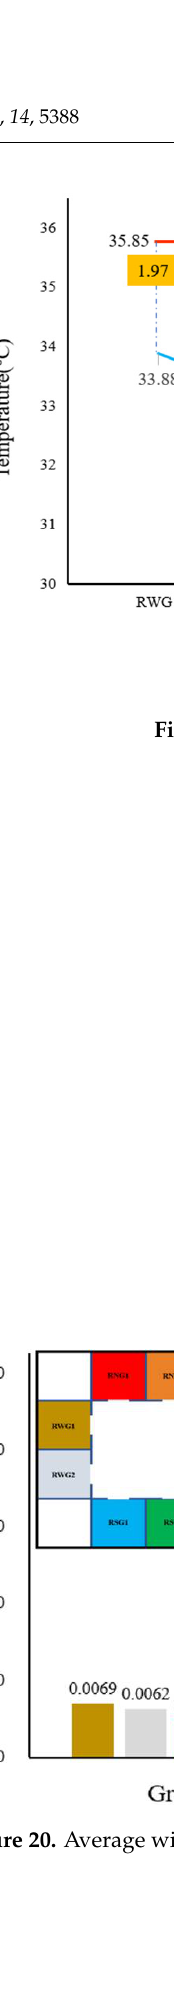
Figure 20. Average wind speed magnitude (m/s) in each room for the baseline courtyard model with four small trees.